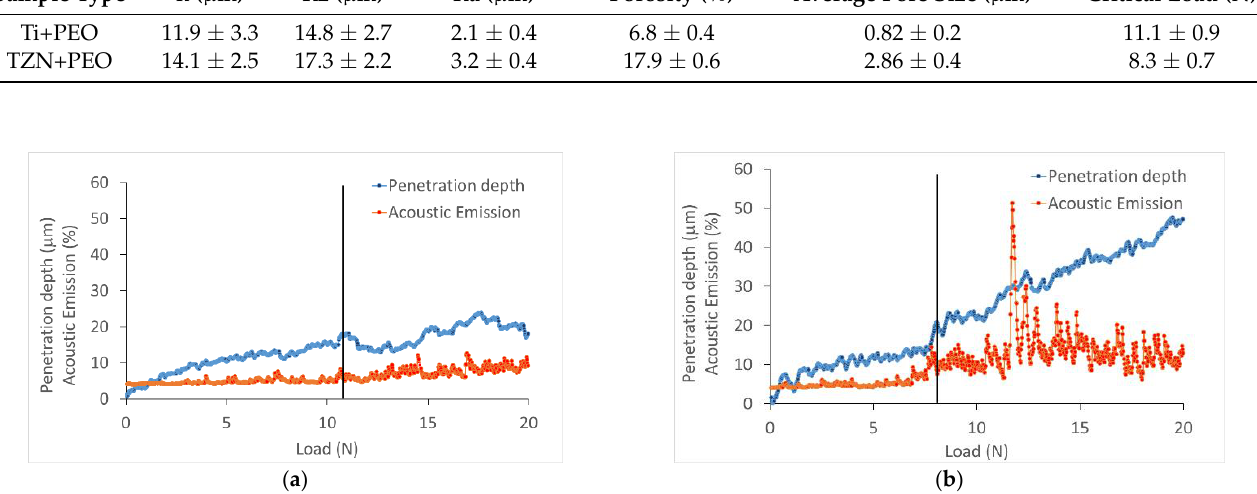
Figure 3. Scratch test results of Ti+PEO ( a ) and TZN+PEO ( b ) coatings; vertical lines represent the critical load values.